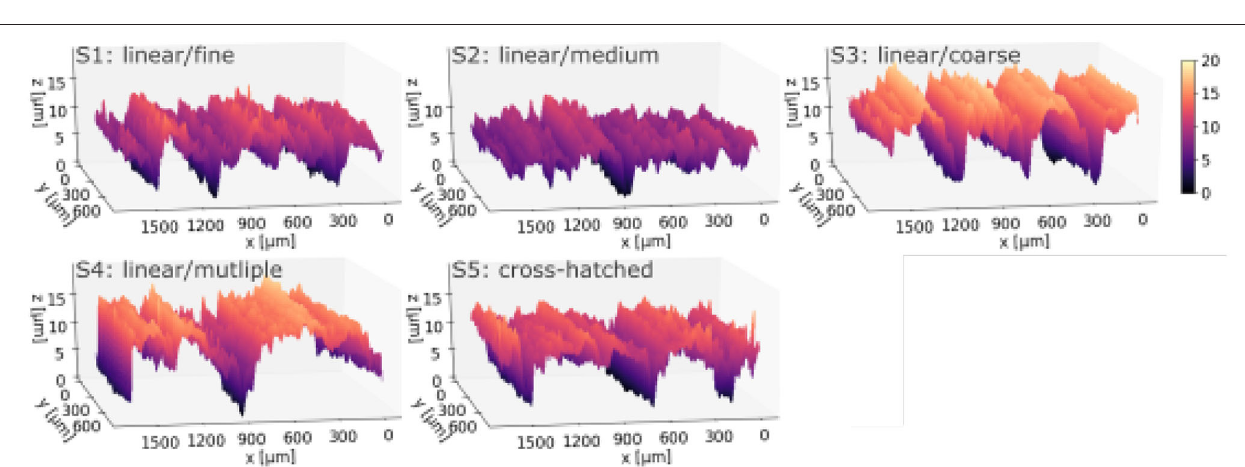
FIGURE 4 | 3D images of the grinding structures